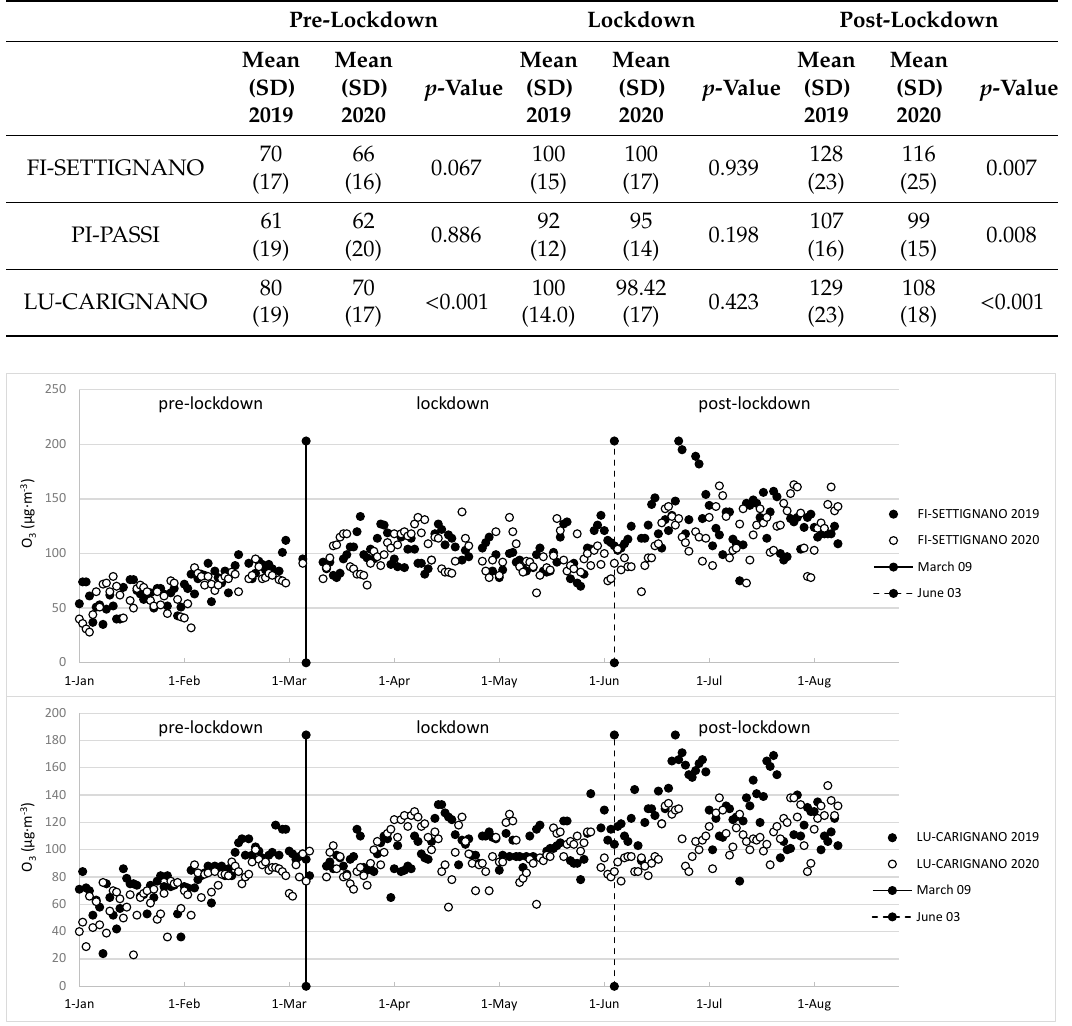
Figure 5. The daily mean concentration of O 3 ( μ g ∙ m − 3 ). The area between the vertical bars in each graph indicates the duration of the lockdown.